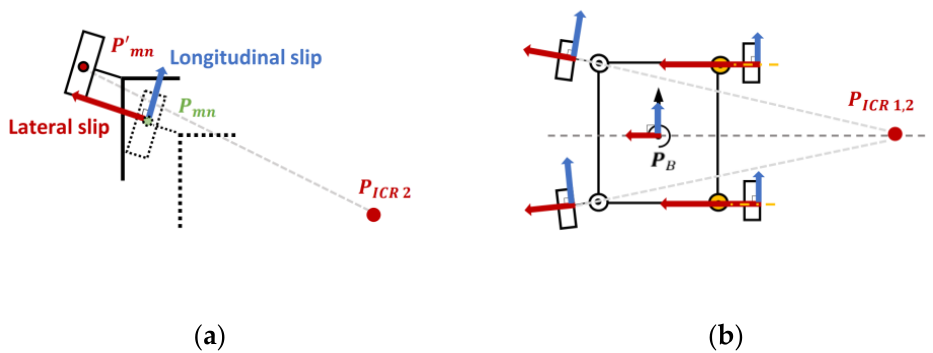
Figure 7. Slip dynamics when the right steering motor malfunctions. ( a ) Changes in the rotation center point position of each wheel due to slippage. ( b ) Change in the center point position of the robot body due to the slip of each wheel, and its recursive effect, causing further slip to occur in the four wheels.